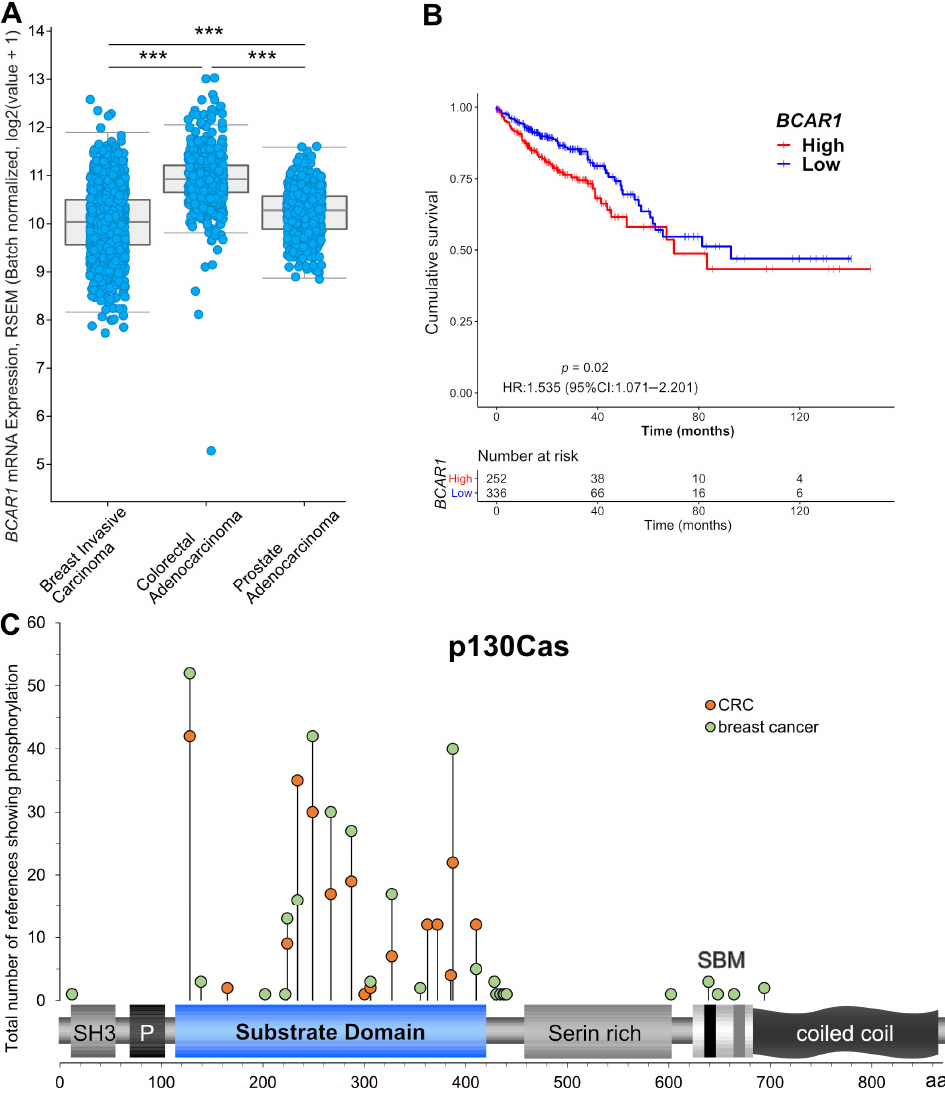
Figure 1. BCAR1 /p130Cas is strongly expressed in and associated with reduced survival of colorectal cancer patients (TCGA data set). ( A ) BCAR1 expression was compared in the indicated TCGA PanCancer Atlas data sets by Kruskal–Wallis test (*** p < 0.0001). ( B ) Overall survival (OS) of patients of the TCGA CoAd cohort expressing high (red curve) or low (blue curve) BCAR1 levels. HR, hazard ratio. CI, confidence interval. ( C ) Number of studies showing phosphorylation of certain motifs in the different p130Cas domains in CRC and breast cancer as curated at PhosphositePlus. P, proline-rich domain. SBM, bipartite Src binding